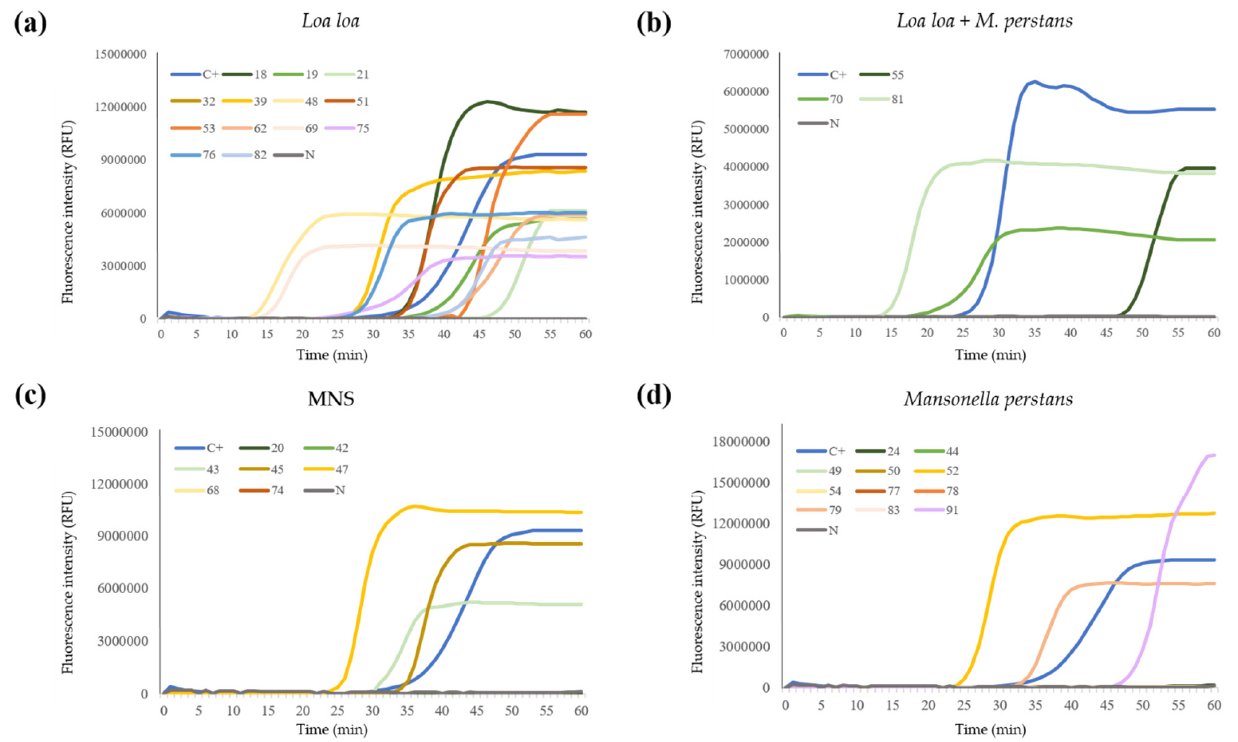
Figure 2. Detection of Loa loa in dried blood samples by real-time LAMP. The figure shows the results detected by fluorescence measured in relative fluorescence units (RFU) in a PCRmax Eco 48 Real-Time qPCR System: ( a ) Loa loa , Loa loa - microscopy positive samples. ( b ) Loa Loa + M. perstans , Loa loa and Mansonella perstans -microscopy positive mixed samples. ( c ) MNS, microscopy negative samples. ( d ) Mansonella perstans , M. perstans -microscopy positive samples. C+, Loa loa positive control